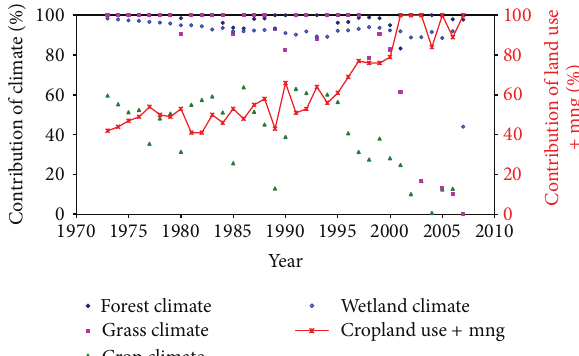
Figure 7: The contribution of climate variation and changes in land use (crop rotation in this case) and management practices to the annual SOC change (i.e., the difference in SOC stock from that in the previous